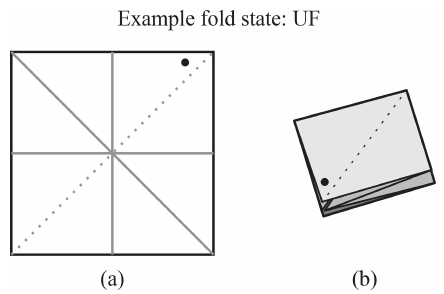
Figure 16. A crease pattern (a) with fold-angle assignment that will result in a UF fold state (b) . The legend for fold-angle assignment is given in Fig. 8. The UF state can gain added degrees of freedom if the unfolded creases are collinear. For example, the fold state could fold along the dotted